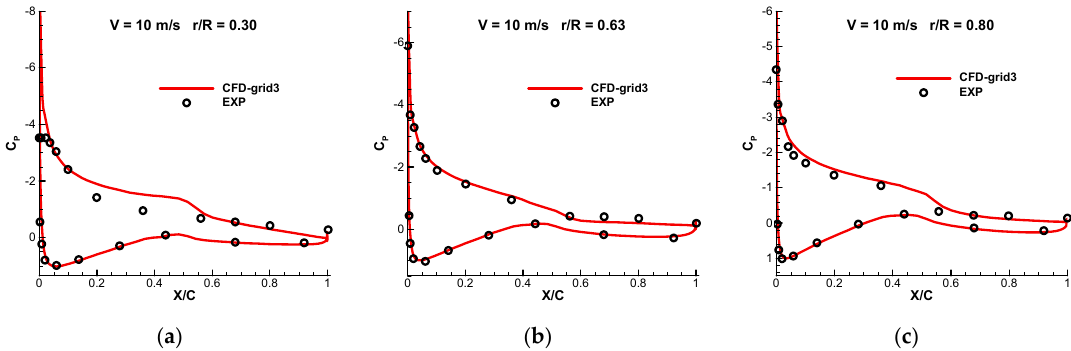
Figure 10. Comparison of pressure distributions between experimental data and present results (wind speed 7 m/s): ( a ) r/R = 0.30; ( b ) r/R = 0.63; ( c ) r/R = 0.80.